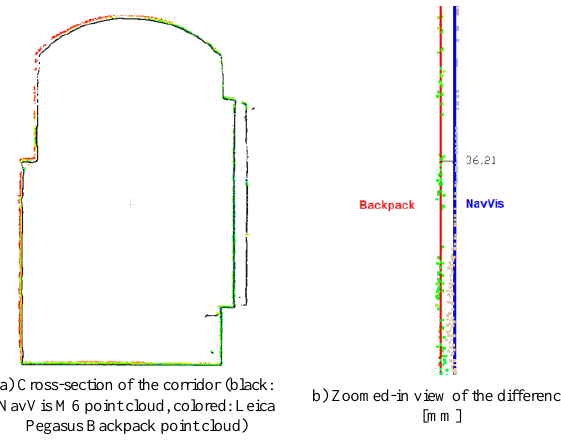
Figure 15 3 rd cross-section of the corridor’s point